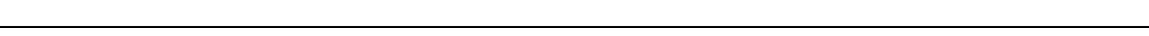
Fig. 5 Txnrd1 -de fi cient T cells have defective nucleotide biosynthetic pathway. Magnetically sorted T cells from spleen and peripheral LNs of Txnrd1 fl / fl (WT) and Txnrd1 fl / fl ; Cd4-Cre mice (KO) were stimulated in α CD3/CD28-coated plates for 2 days in vitro. a Oxygen consumption rate (OCR; left) and extracellular acidi fi cation rate (ECAR; right) were measured with a Seahorse Extracellular Flux XF-96 analyzer under basal conditions and following addition of the indicated metabolic inhibitors ( n = 6; data are mean + standard deviation). b Western blot of p-AMPK expression with β -actin as a loading control in T cells. c – e Metabolites were analyzed by non-targeted metabolomics (four replicates were examined, each analyzed twice). c Depicted is the ATP-to- AMP ratio. d Metabolic pathway enrichment analysis comparing WT and KO T cells both before and after stimulation. KO > WT and WT > KO indicate higher metabolite levels in KO and WT T cells, respectively. e Box plots displaying cellular ribonucleotide levels in WT and KO T cells. Numbers in brackets represent the mass-to-charge ratio of the detected ions. f Ribonucleotide and 2 ′ -deoxyribonucleotide metabolites were analyzed by targeted metabolomics at 0 and 48 h after stimulation ( n = 4). Bar graphs are mean + standard deviation ( c , f ). The boxes represent the 25th to 75th percentiles, the horizontal lines within the boxes indicate the medians, and the whiskers are drawn to indicate the 1.5 × Inter Quartile Range (3rd quartile – 1st quartile; e ). Data are representative of two independent experiments ( a – f ). Student ’ s t test (two-tailed, unpaired) was used in c , f : * P ≤ 0.05; ** P ≤ 0.01; **** P ≤ 0.0001. P -values were adjusted using Benjamini – Hochberg procedure ( d ). Signi fi cance of the box plot data was assessed using a Student ’ s t test (two-tailed,